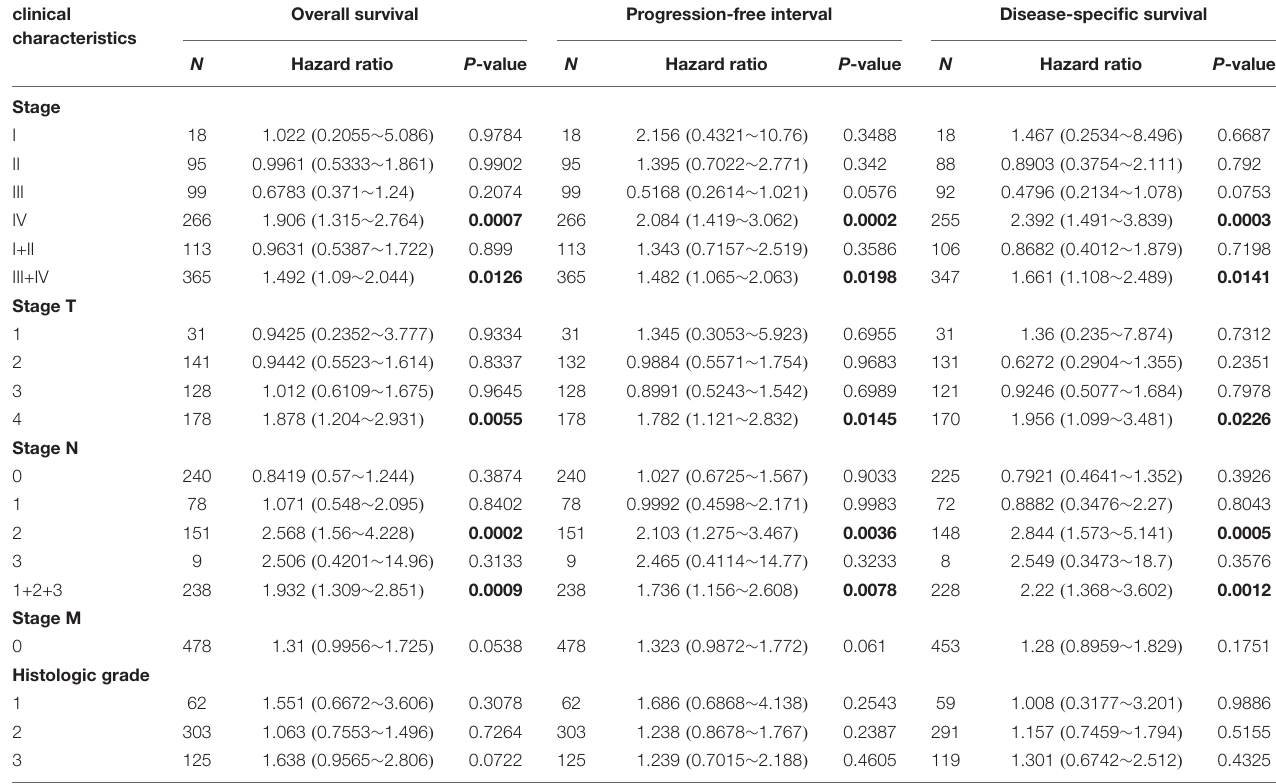
TABLE 1 | The correlation of IFI44 mRNA-seq data with the survival analysis in HNSC patients. clinical